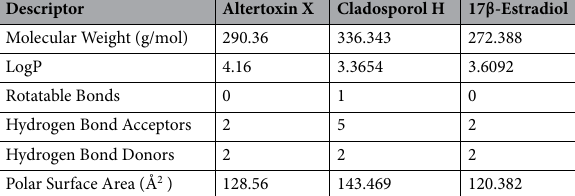
Table 3. Chemical structural properties of the selected